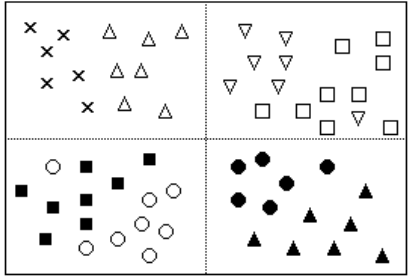
Figure 1. Cluster splitting in an eight-class example.